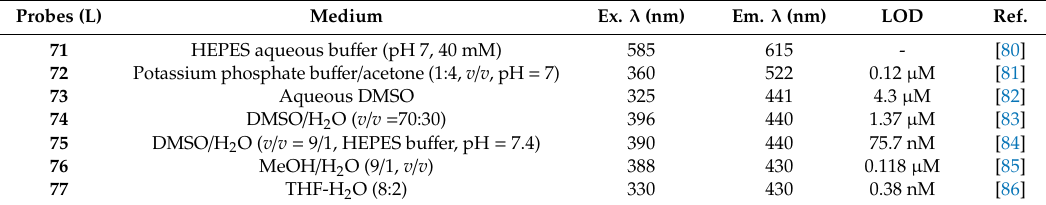
Table 4. Physiochemical properties of some iron(III) selective reaction-based fluorescent probes. Probes (L) Medium Ex. λ (nm) Em. λ (nm) HEPES aqueous bu ff er (pH 7, 40 mM) Potassium phosphate bu ff er / acetone (1:4, v / v , pH =